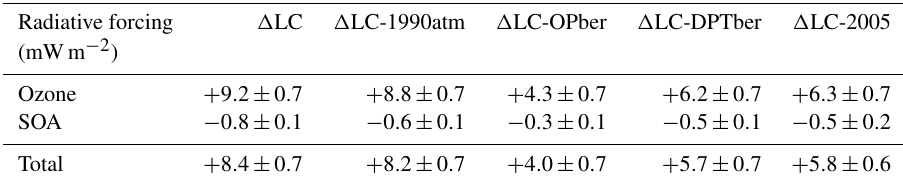
Table 5. Global annual-mean radiative forcing (mWm − 2 ) from changes in atmospheric composition induced by maritime Southeast Asian land cover change. Mean ± 1 standard deviation, calculated over 10 model